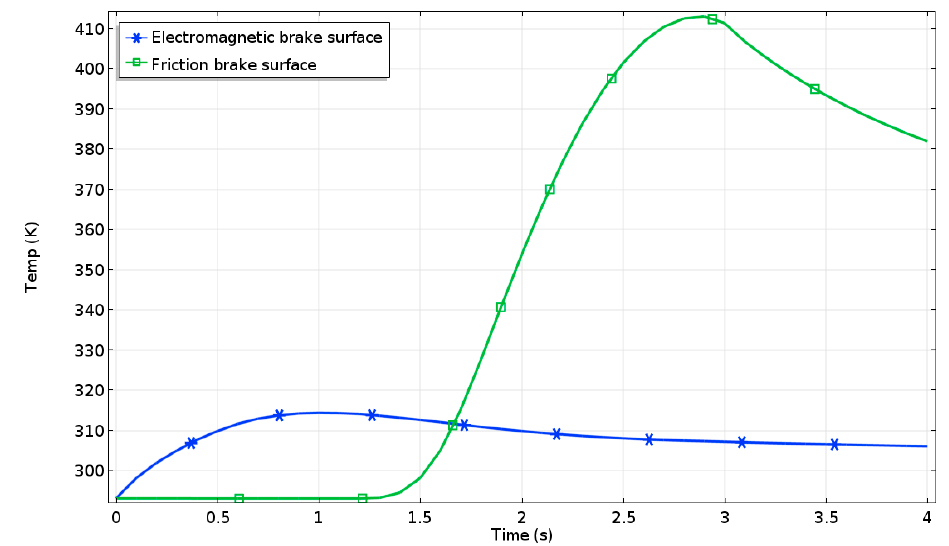
Figure 6. Temperature curves of integrated brake disc during emergency braking.